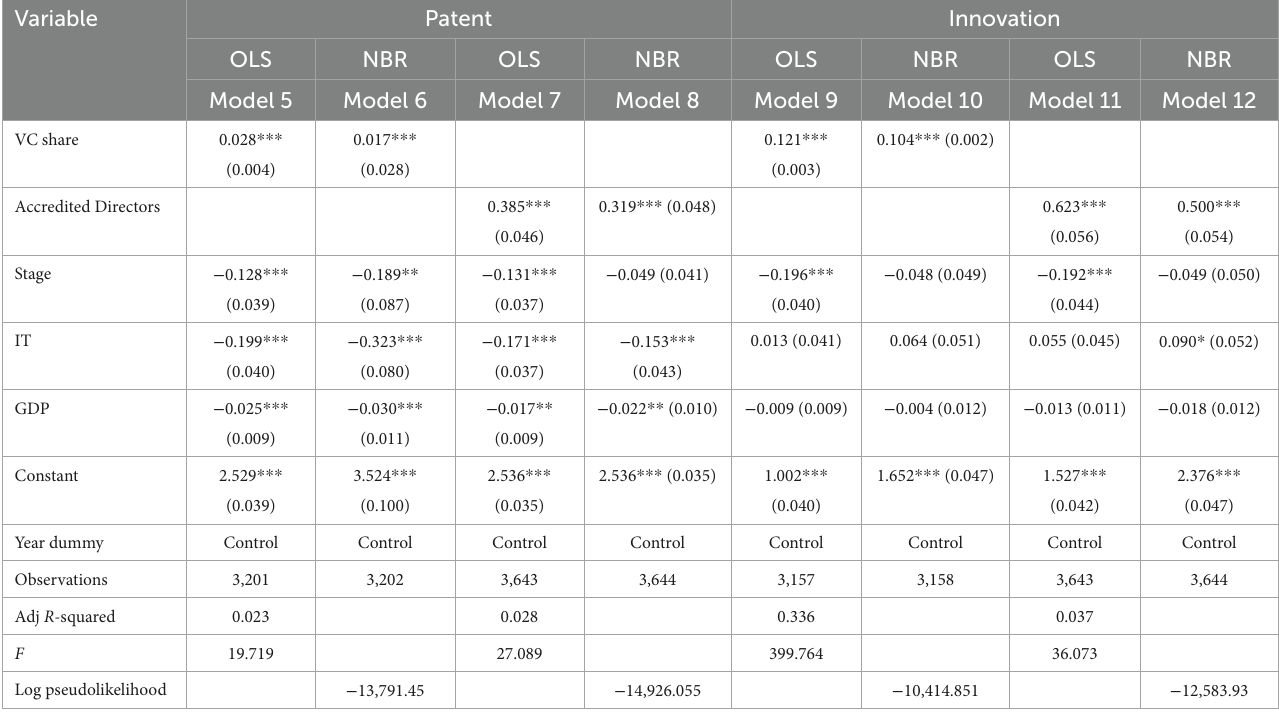
TABLE 4 Impact of VC shareholding and dispatched directors on enterprise innovation performance.